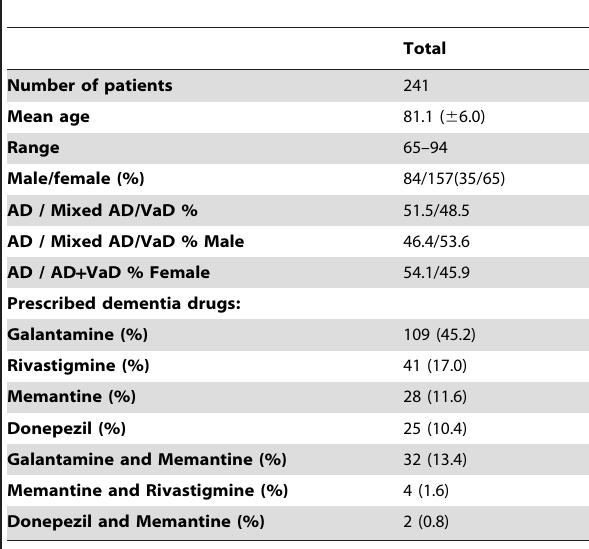
Table 2. Baseline data for patients from dementia clinics and prescribed dementia